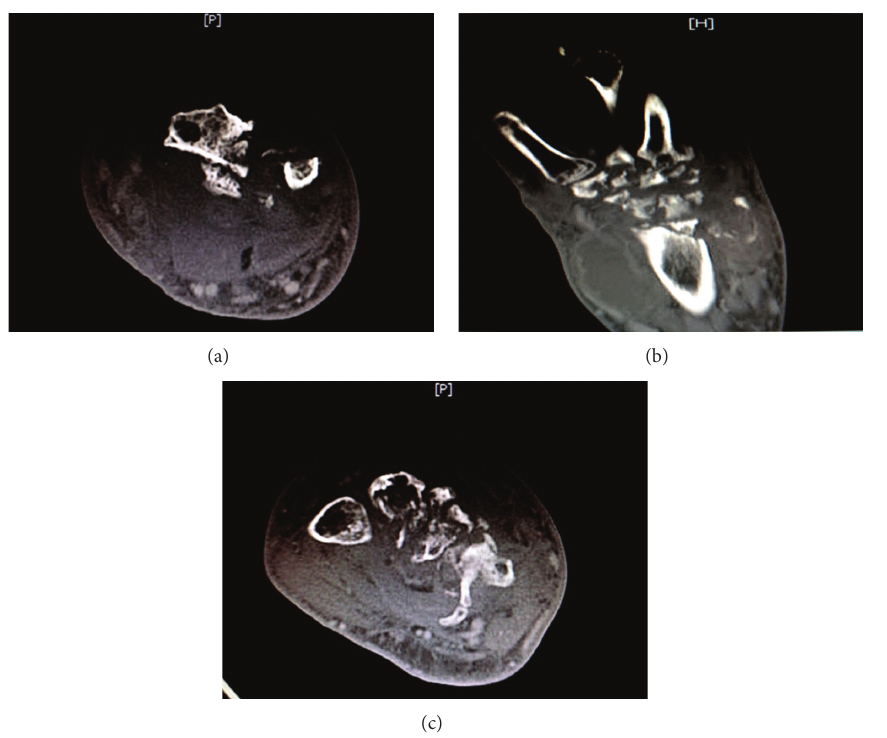
Figure 2: (a) CT wrist transverse section: destructive changes involving distal radius and ulna associated with septated fluid collections with enhancing borders. (b) CT wrist longitudinal section: destructive changes seen in distal radius/ulna, carpal bones, and bases of metacarpals. Pyogenic collections seen surrounding the wrist joint. (c) CT wrist transverse section: destructive changes seen involving the bases of metacarpals in septic arthritis with surrounding pyogenic